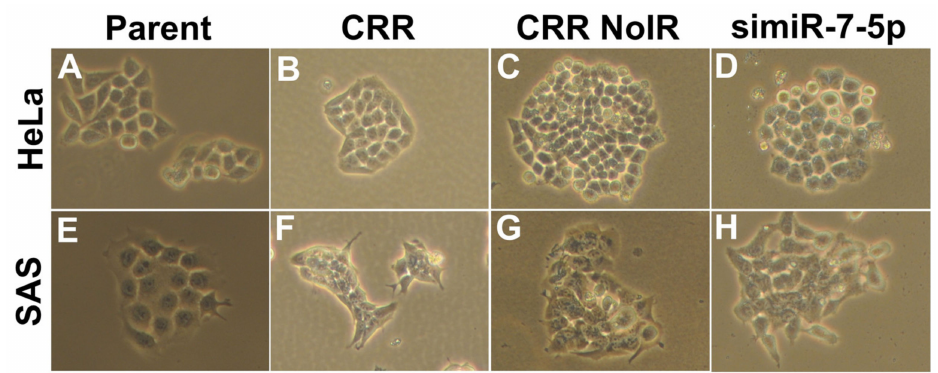
Figure 8. Morphology of parent, CRR, NoIR, and simiR-7-5p cells. Morphology of the cells was observed under the optical microscope with 10 × eyepieces and 10 × objective lenses (magnification: 100 × ). ( A ) HeLa parental cells. ( B ) HeLa CRR cells. ( C ) HeLa CRR NoIR cells. ( D ) HeLa CRR cells that were knocked down by miR-7-5p. ( E ) SAS parental cells. ( F ) SAS CRR cells. ( G ) SAS CRR NoIR cells. ( H ) SAS CRR cells that were knocked down miR-7-5p. NoIR cells were cultured without 2 Gy/day irradiation for over 1 year and lost radioresistance. The cell shape of CRR cells looks small and tightly aggregated compared with that in parental cells. These characteristics are similar in NoIR cells, which lose radioresistance. Conversely, when miR-7-5p is knocked down, the cell–cell connections appear to loosen like the parental